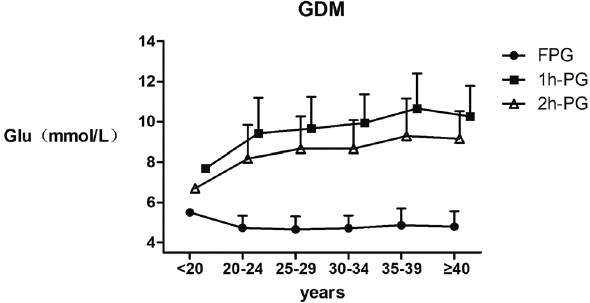
Figure 3: The levels of fasting plasma glucose (FPG), 1 h PG and 2 h PG among the maternal age subgroups in gestational diabetes mellitus (GDM) pregnant women.